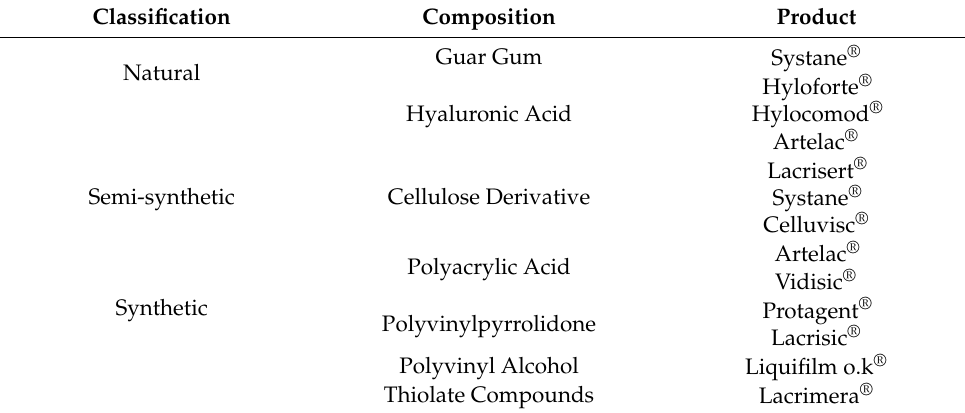
Figure 5. Schematic illustration for the preparation ( a ) and characterization ( b – g ) of anti-inflammatory and antioxidant micelles. Reprinted from [80] under Creative Commons Attribution License. Table 2. Bioadhesive polymers for the treatment of DED